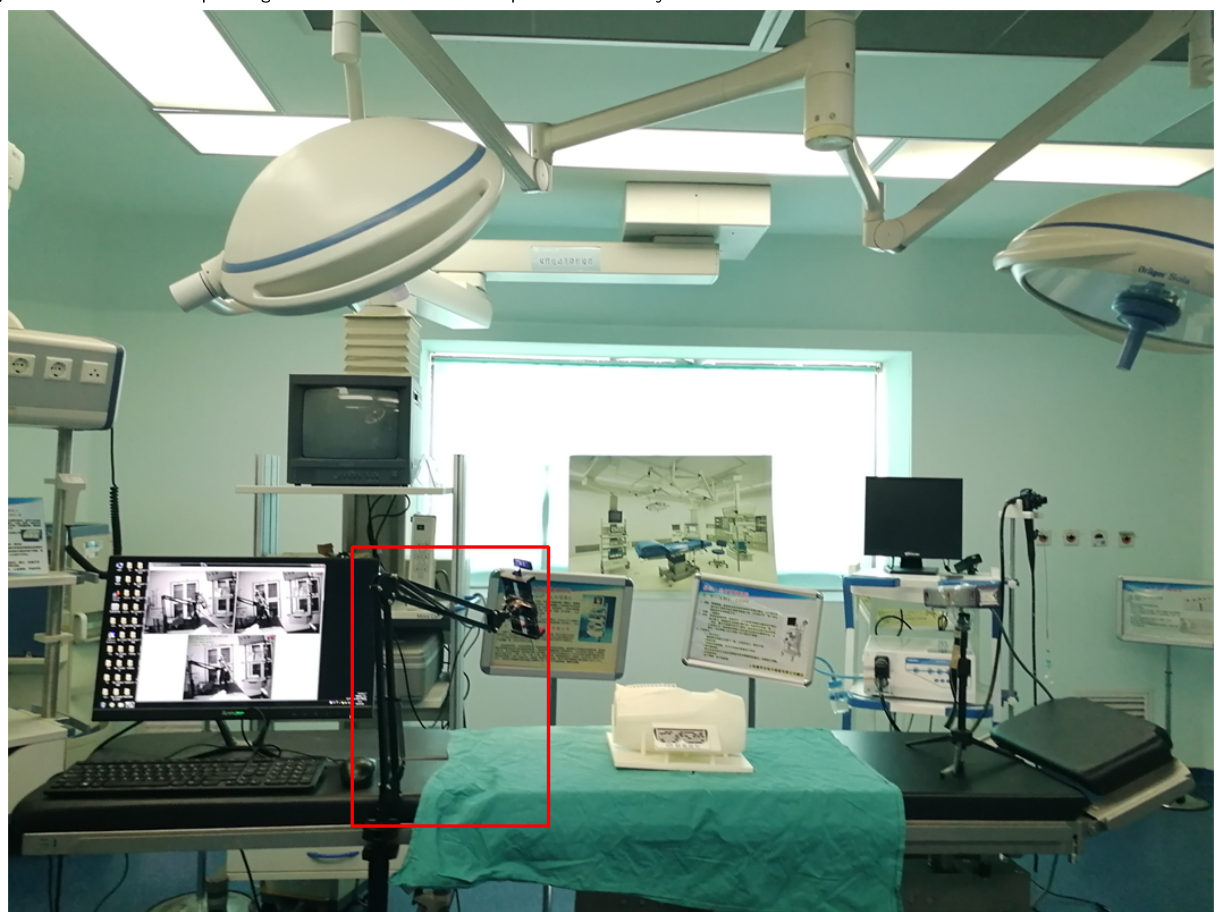
Figure 2. The simulated operating room used for the test. The probe was held by a mechanical